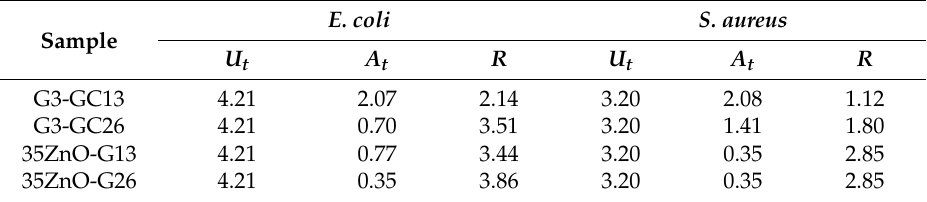
Table 2. In vitro antimicrobial activity: U t is the average of the common logarithm of the number of viable bacteria, in cell/cm 2 , recovered from the untreated test specimens after 24 h; A t is the average of the common logarithm of the number of viable bacteria, in cell/cm 2 , recovered from the treated test specimens after 24 h. R is the antibacterial activity. R = U t − A t .